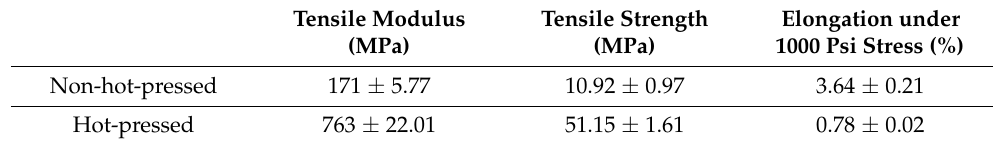
Table 2. Mechanical properties of BI-PI NFMS.